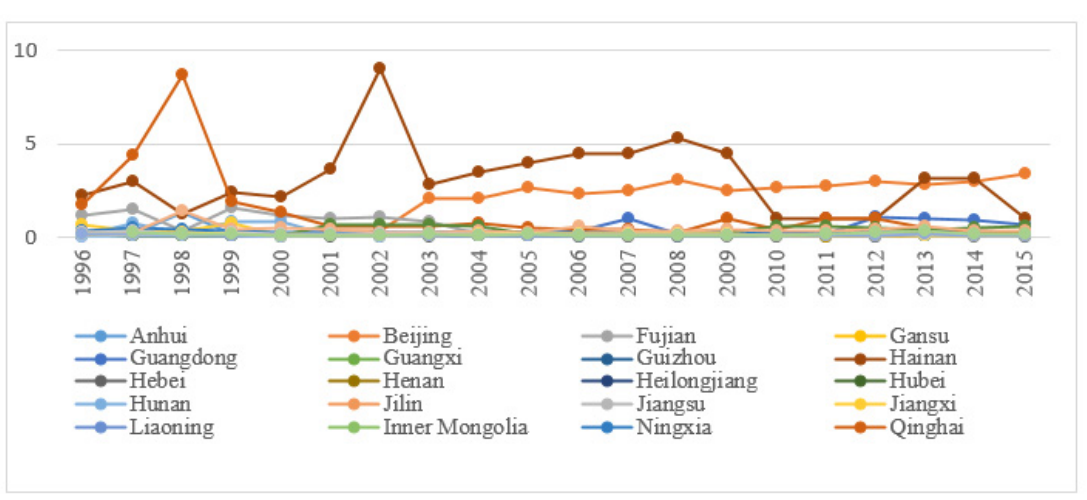
Figure 6. The provincial environmental treatment efficiency of China. (Source: Authors compiled).